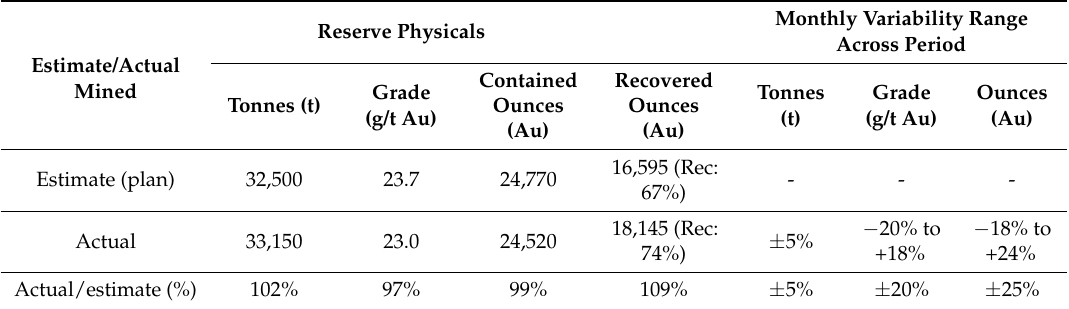
Table 23. Summary of half year production reconciliation of selective mining the